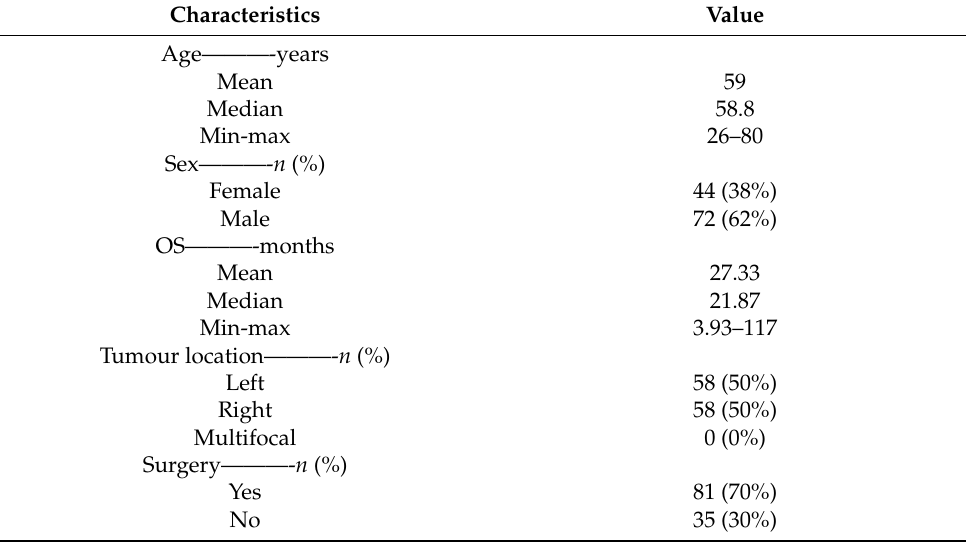
Table 1. Patient characteristics of the validation